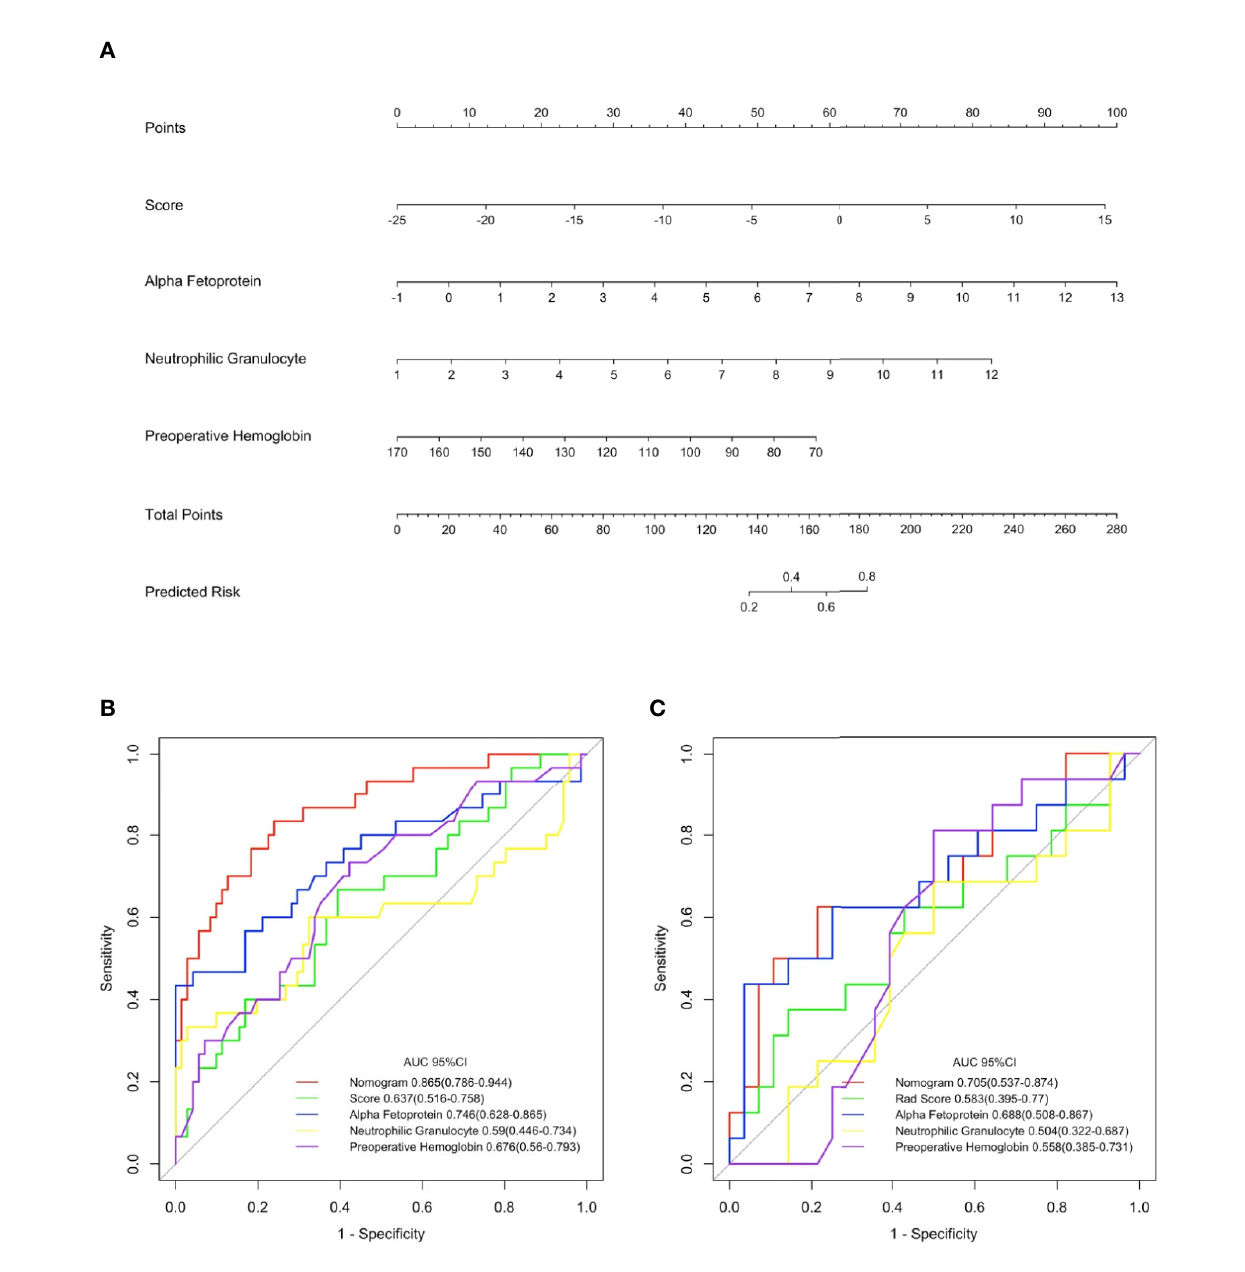
FIGURE 3 | Nomogram for the prediction of the tumor with microvascular invasion occurring or not and its discrimination performance. (A) data among the training cohort were employed to establish the purposed monogram which the Rad-score, alpha fetoprotein, neutrophilic granulocyte and preoperative hemoglobin were incorporated. Instructions for reading the nomogram: Find the Rad-score in the Rad-score axis; a straight line was drew to the point axis and the intersection point stands for actual points of the predicted probability which a patient with microvascular invasion (MVI) occurrence or not according to the own Rad-score; repeat above mentioned procedures for another predictors each straight line was drew to the points axis; calculated the total points obtained from each predictor and located it on the total points axis; draw a line perpendicular to the predict risk axis to determine the patient ’ s risk (24). (B, C) display the result of ROC curves analysis for the nomogram and each individual predictor in predicting whether tumors with microvascular invasion occurred among the training and validation cohorts,